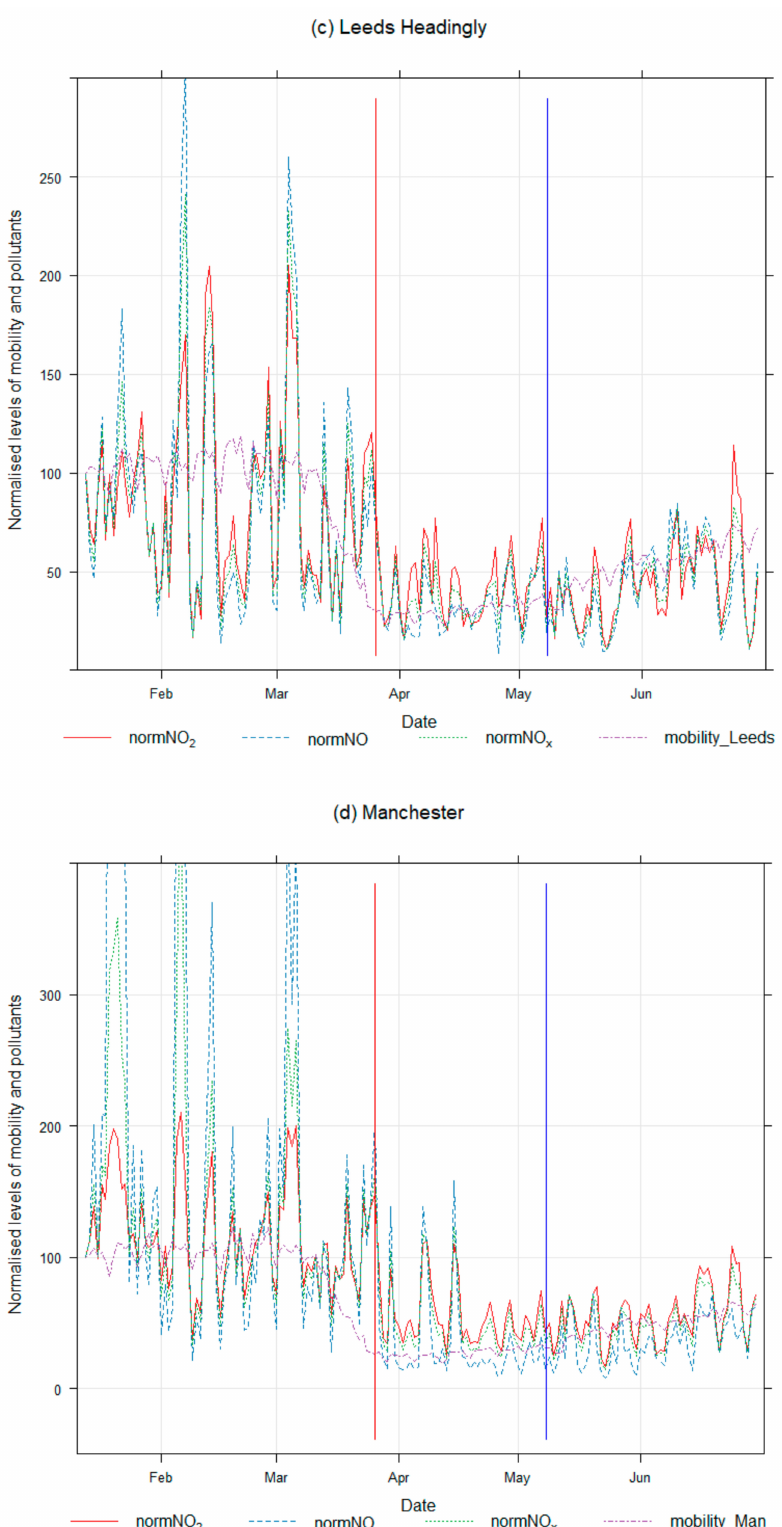
Figure 9. Time series plots between normalised daily mean (%) mobility data and air pollutant concentrations at all AQMS January to June 2020. January 13 is taken as the baseline for normalisation. Vertical red and blue lines show the start and end of the lockdown period, respectively. ( a ) Sheffield Barnsley; ( b ) Sheffield Devonshire Green; ( c ) Leeds Headingley and ( d )